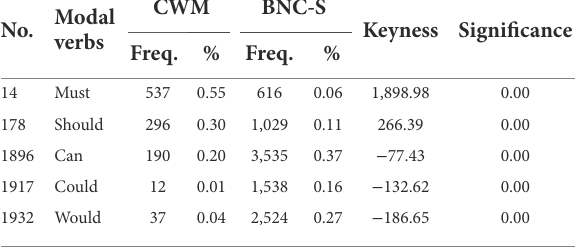
TABLE 18 Quantitative values of modal verbs (Halliday and Matthiessen, 2004: